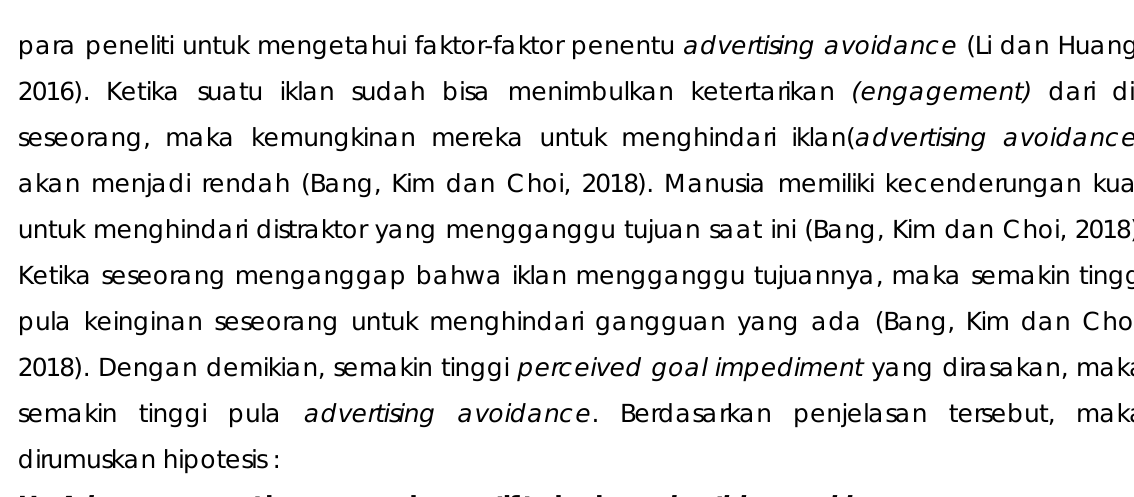
H 8 : Ad engagement berpengaruh negatif terhadap advertising avoidance. H 9 : Perceived goal impediment berpengaruh positif terhadap advertising avoidance.